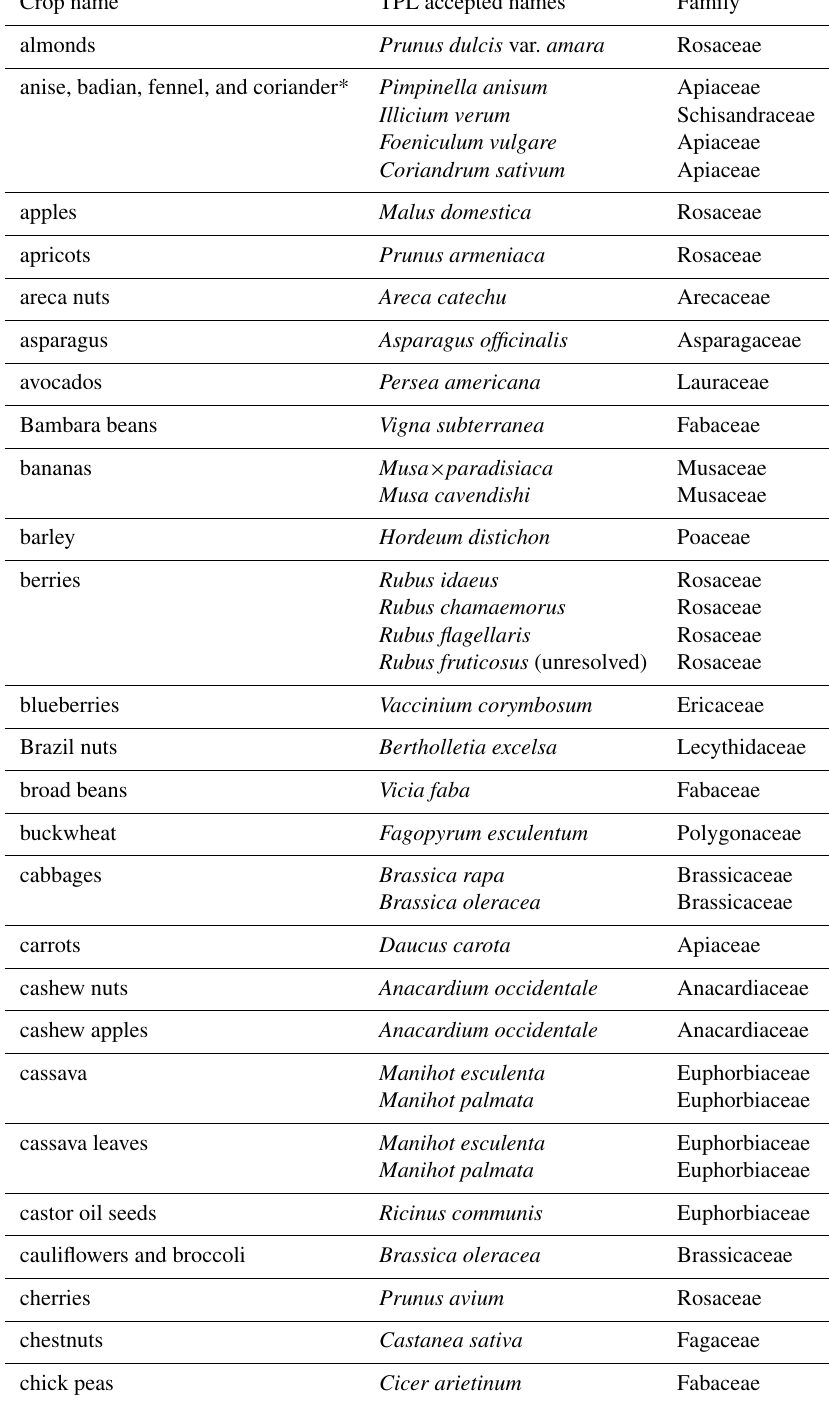
Table A1. FAO crops/items included in the study, with their corresponding species names and family. Listed species names are accepted names according to The Plant List (TPL). Items indicated with an asterisk were not included in the analyses, as they include species phylo- genetically